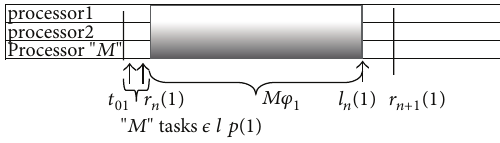
Figure 4: Work area 𝑀𝜑 1 of 𝜏 1 .